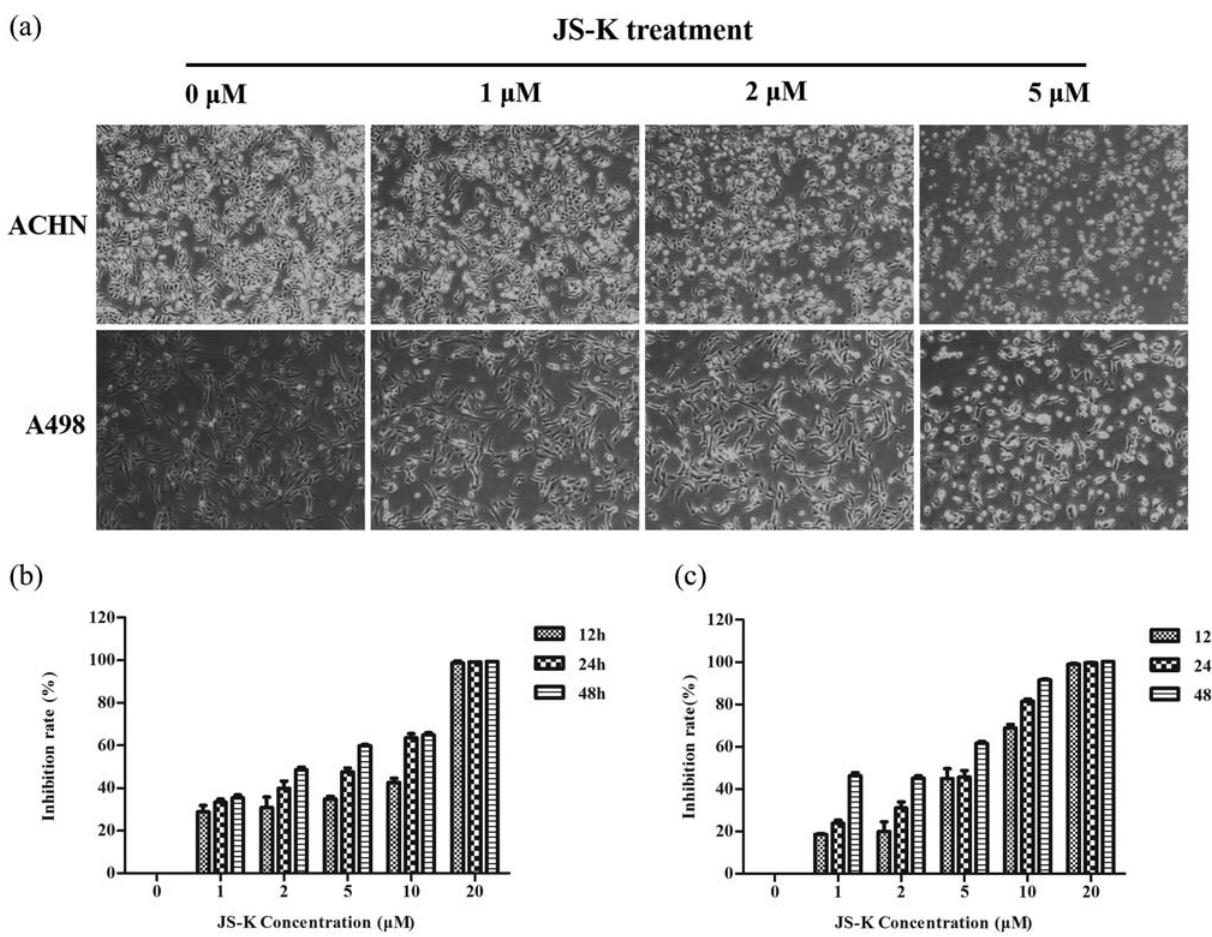
Figure 2: JS - K treatment inhibits renal carcinoma cell proliferation in a dose - and time - dependent manner. ( a ) Visualized apoptosis caused by microscopy of JS - K in ACHN and A498 cells at 24 h ( 100 ×) . ( b and c ) Cells were exposed to various JS - K concentrations ( 1, 2, 5, 10, and 20 μ M ) for 12, 24, and 48 h, with an inhibition rate of 0%. Thus, every sample was recreated, and three separate assays ( n = 3 ) are shown in the fi gure. The fi ndings are presented as mean ±